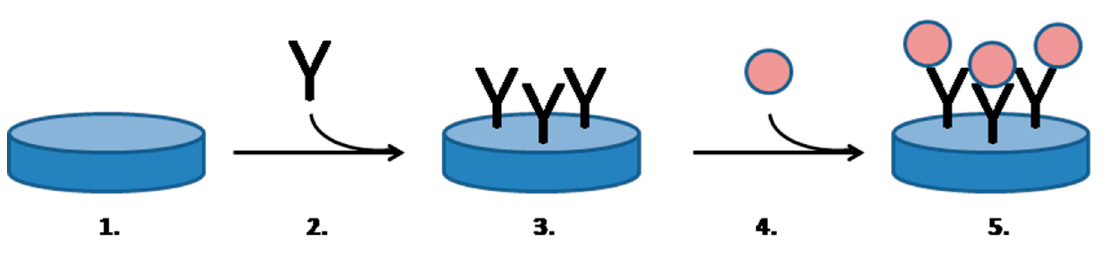
Figure 4. An idealized principle of piezoelectric function. Meaning of numbers: 1. Pure QCM sensor with high frequency of oscillations; 2. Immobilization of an antibody; 3. Finished biosensor prepared for an assay; 4. Application of a sample containing analyte (a biological warfare agent); 5. Analyte is caught on the biosensor surface and frequency of oscillation is